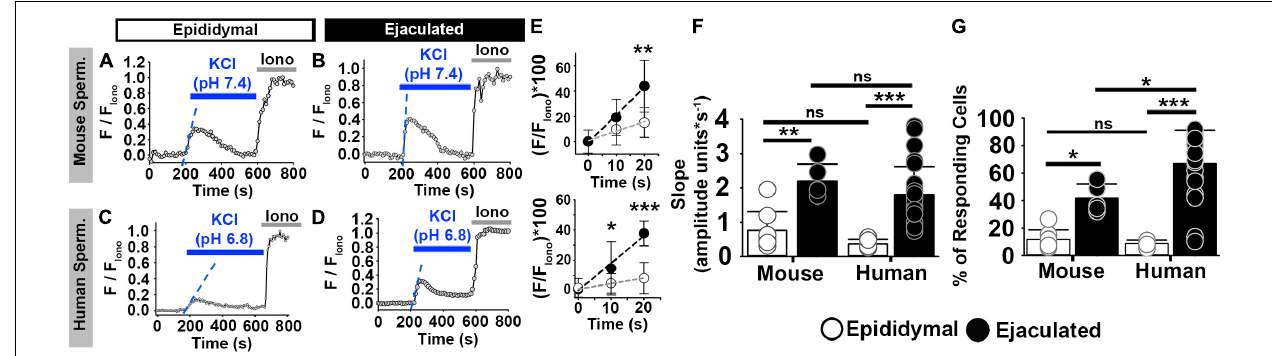
FIGURE 2 | Mouse and human sperm at similar stages of maturation show similar increases in [Ca 2 + ] i in response to KCl. (A–D) [Ca 2 + ] i traces from the epididymal and ejaculated sperm responsive to KCl in non-capacitated conditions. (E) Linear fit of the averaged normalized fluorescence in the first 20 s after KCl addition [blue dashed lines in panels (A–D) ] in responding sperm. (F) Graph of the slope values of the best-fit regression lines. Mean values were as follows: epididymal mouse sperm, 0.76 ± 0.547 amplitude units * s − 1 (8 mice, 307 sperm); ejaculated mouse sperm, 2.20 ± 0.494 amplitude units *s − 1 (5 mice, 170 sperm); epididymal human sperm, 0.36 ± 0.137 amplitude units *s − 1 (5 samples, 191 sperm); and ejaculated human sperm, 1.80% ± 0.82 amplitude units *s − 1 (26 samples, 1836 sperm). (G) Graph of the percentage of responsive sperm. Mean values were as follows: epididymal mouse sperm, 11.80% ± 6.9 (8 mice, 307 sperm); ejaculated mouse sperm, 41.9% ± 10.2 (5 mice, 170 sperm); epididymal human sperm, 8.72% ± 2.54 (5 samples, 191 sperm); and ejaculated human sperm, 66.94% ± 24.30 (26 samples, 1836 sperm). * P < 0.050, ** P < 0.010, *** P < 0.001, and ns, non-significant by one-way ANOVA. Error bars indicate standard deviation. Iono = 5 µ M Ionomycin + 2 mM Ca 2 +